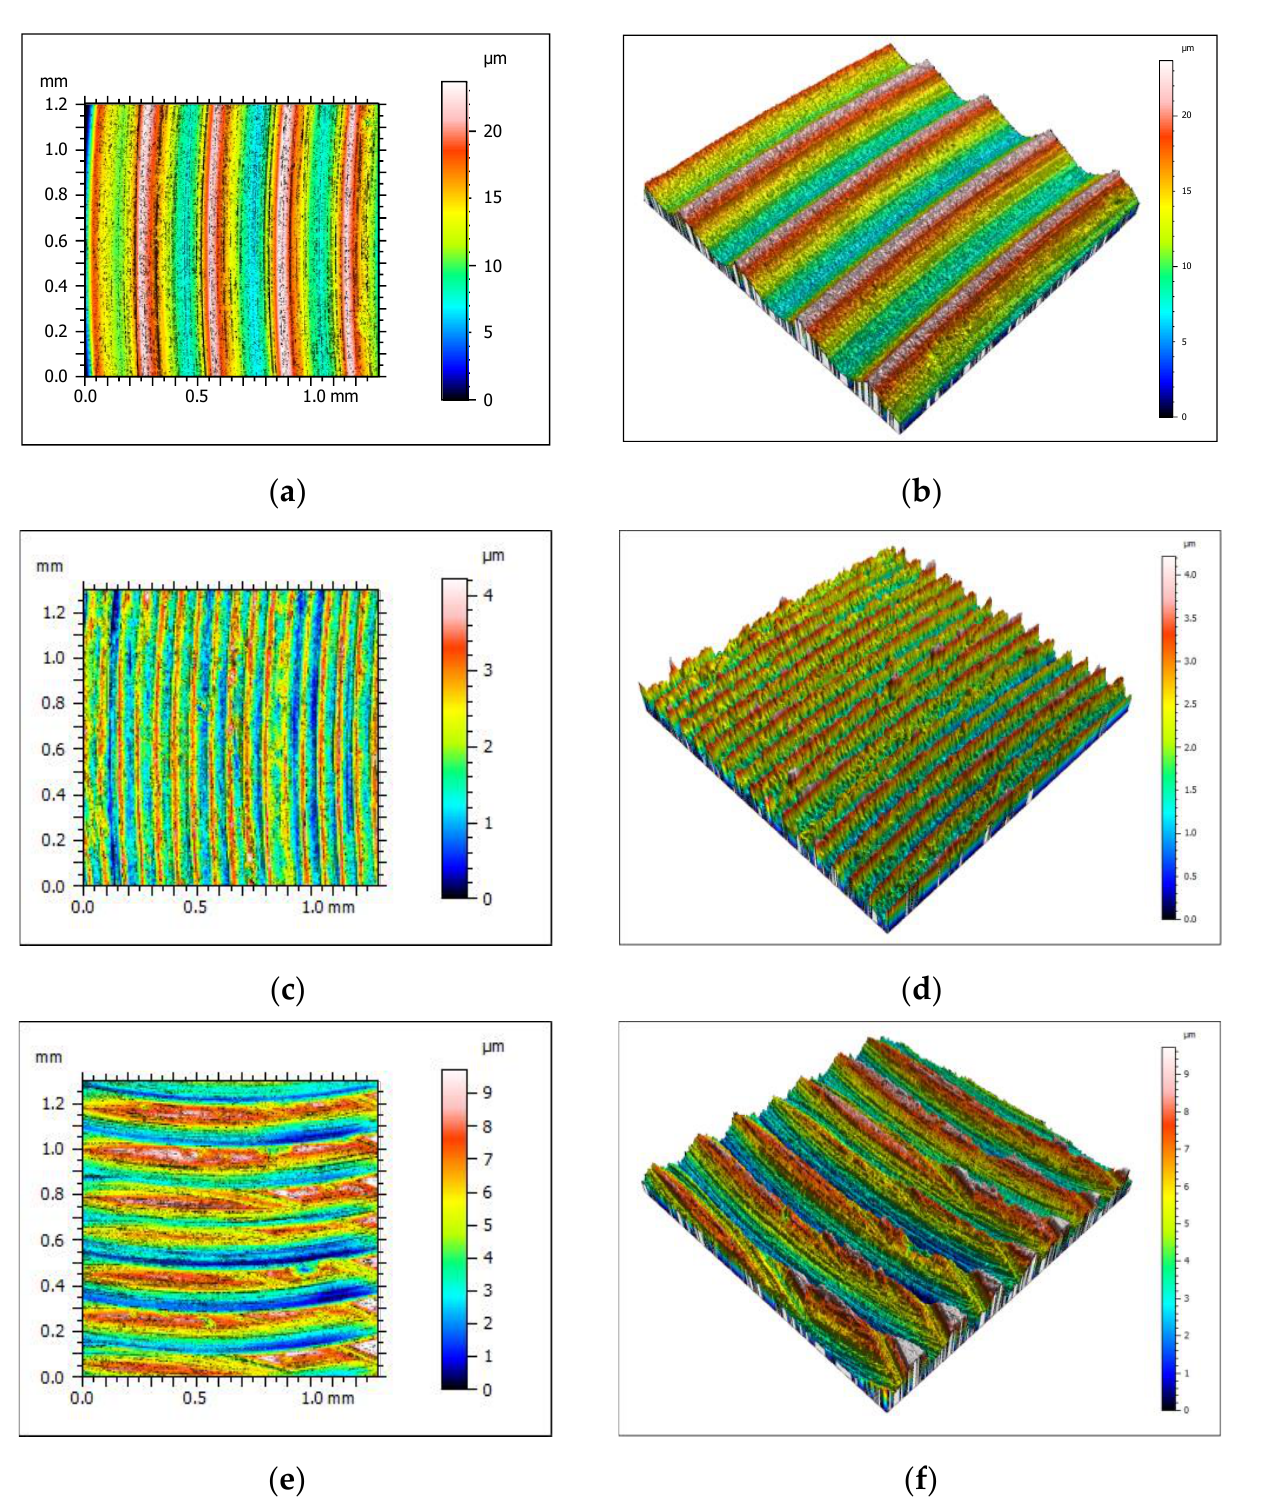
Figure 6. Contour map and isometric view of samples. ( a , b ) Coded A, ( c , d ) coded B, ( e , f ) coded C.